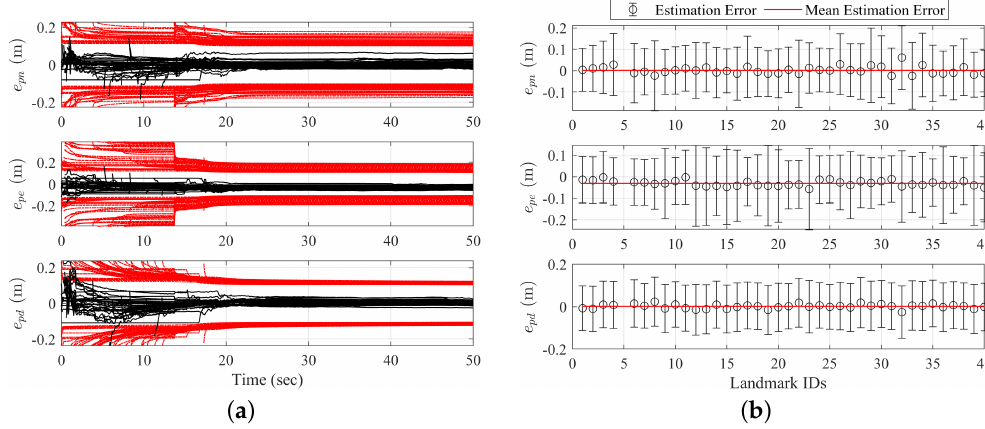
Figure 11. Landmarks state estimation error for an 8-shape trajectory. For 11 a , estimation error ( ), 3 σ boundary ( ); each line signifying estimation error for each landmark over time. ( a ) Estimation error over time and ( b ) estimation error at the